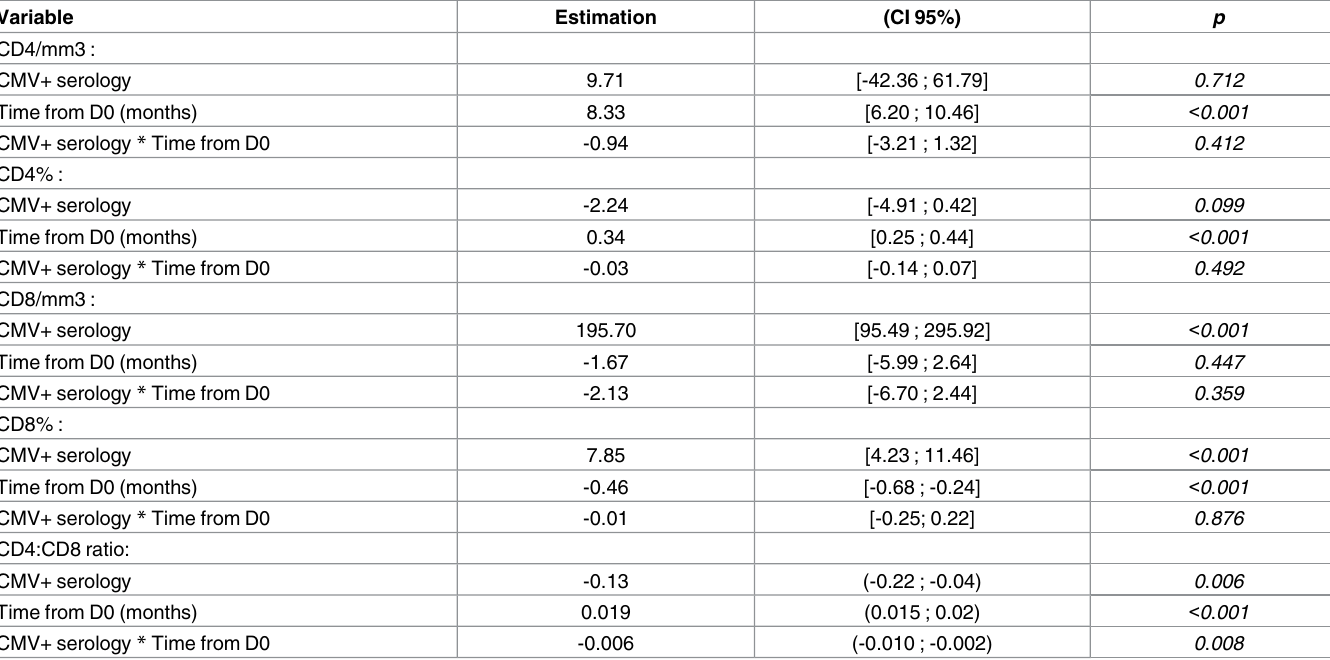
Table 2. Mixed linear analysis of the dynamics of T cell compartments and CD4:CD8 ratio: association with CMV+ serology, time and interaction.